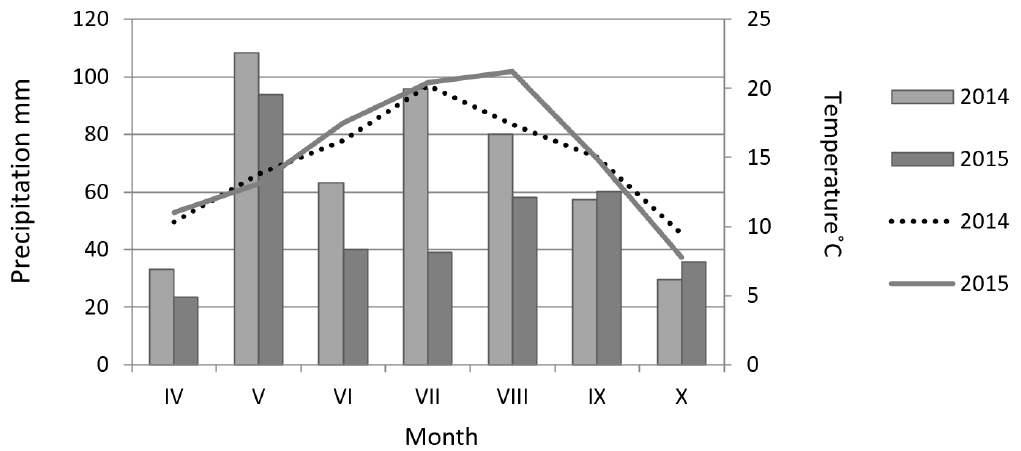
Figure 1. Mean monthly precipitation (mm, chart bars) and temperatures (°C, chart line) during the vegetation period.